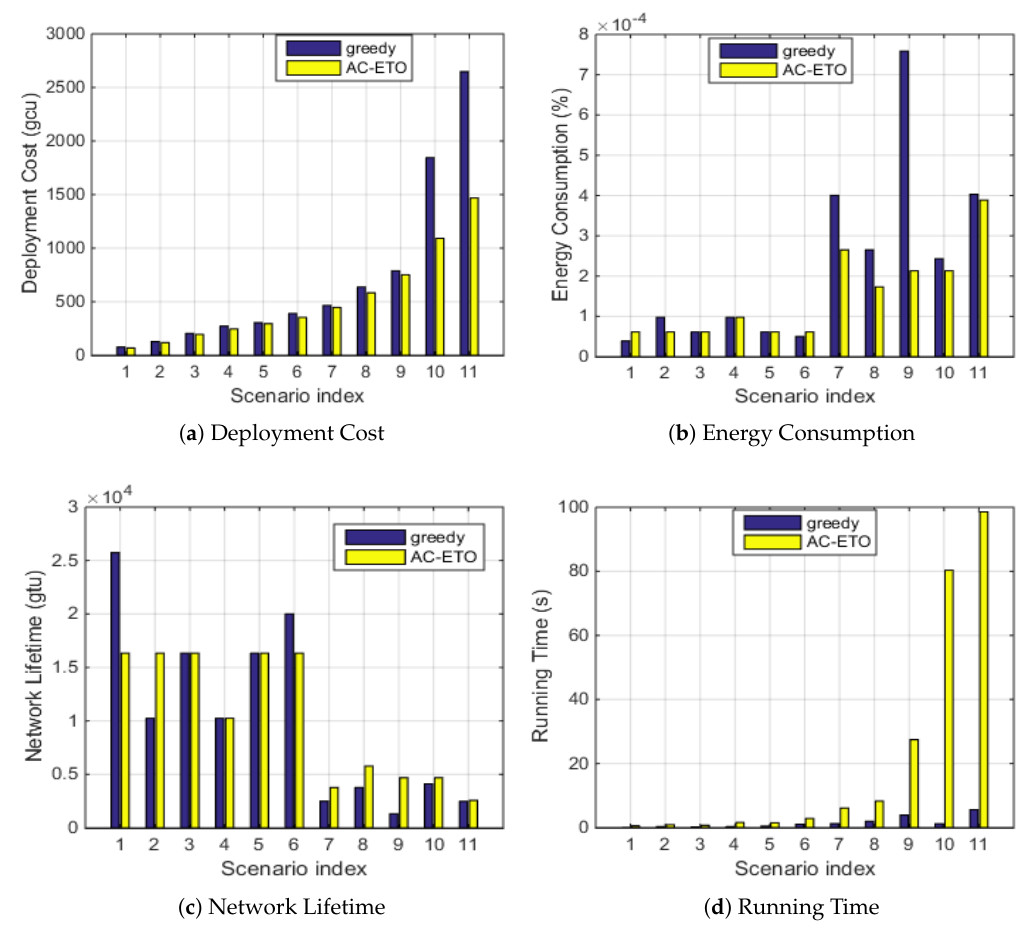
Figure 8. Comparison of AC-ETO and a greedy algorithm in terms of the average deployment cost and energy consumption of twenty execution times under various